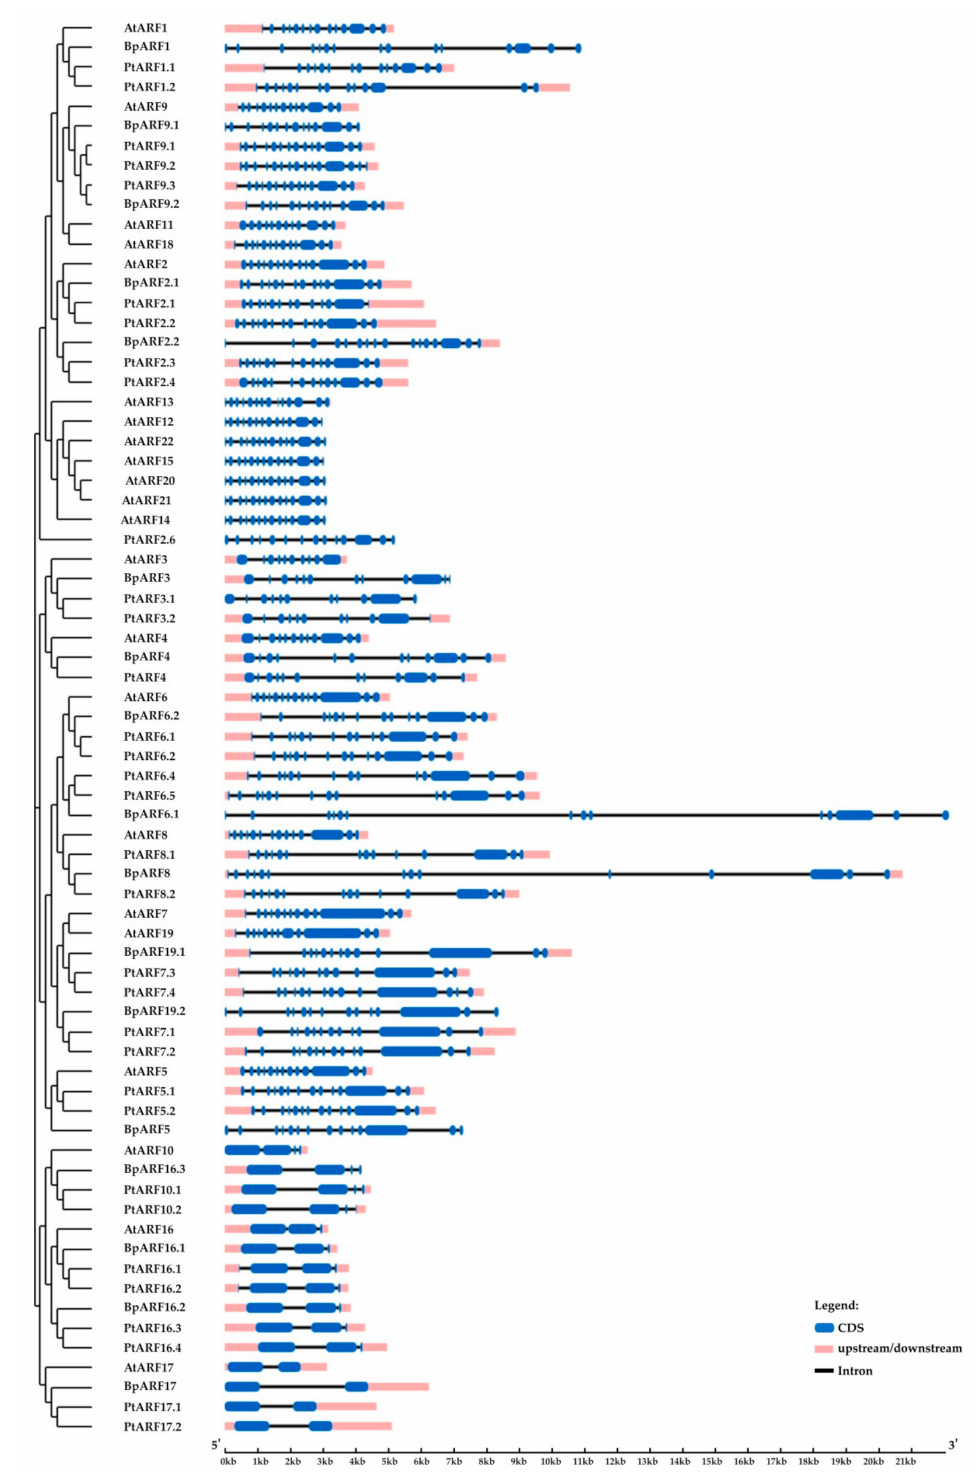
Figure 10. Structure of B. pendula , A. thaliana and P. trichocarpa ARF genes. Intron, exon, and untranslated regions (UTR) are represented by black lines, dark blue boxes, and pink